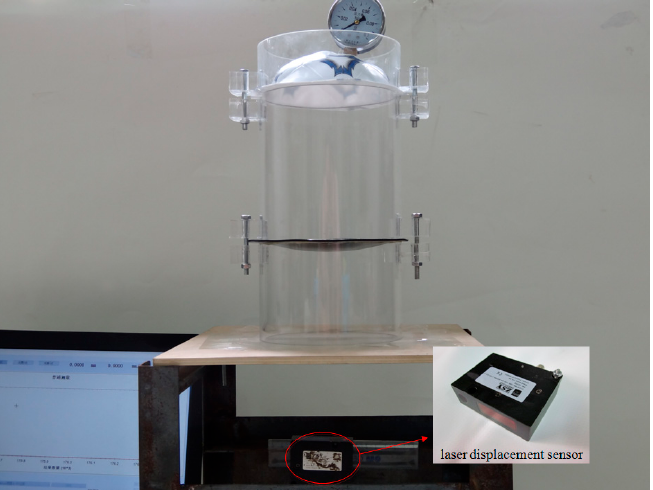
Figure 12. The integral measuring device. Table 2. Results in numerical